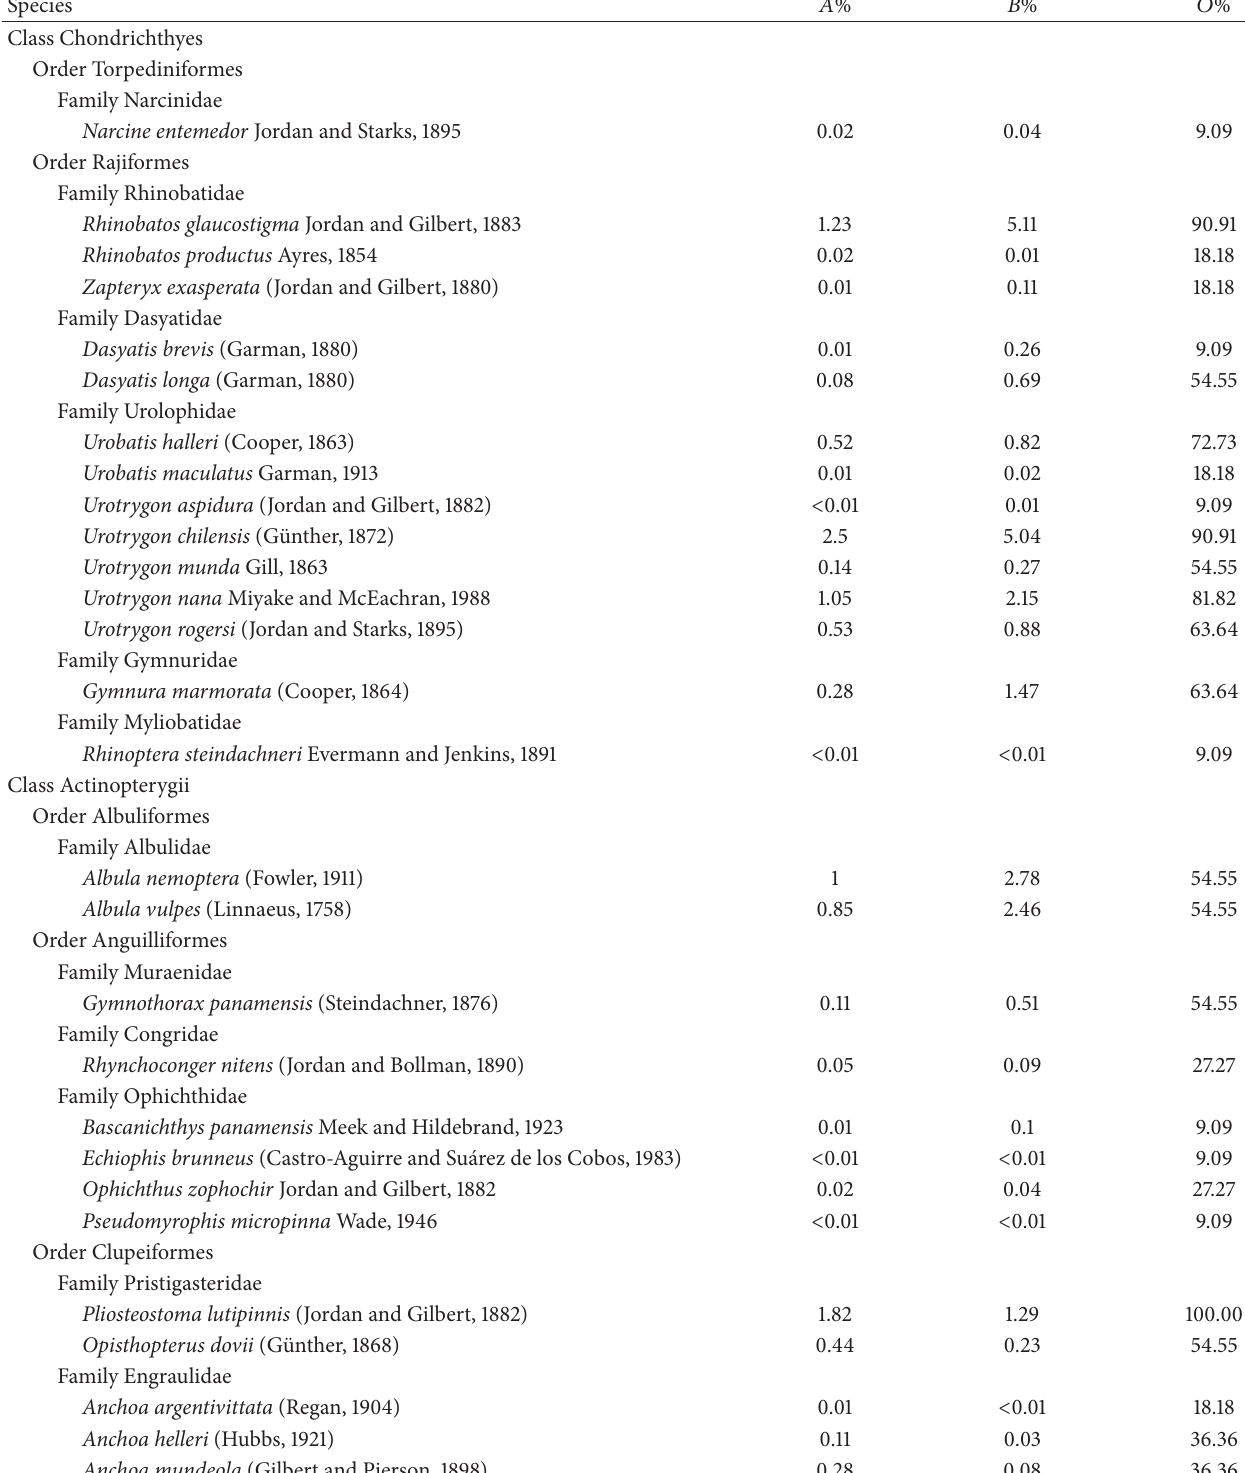
Table 1: Relative abundance ( 𝐴 %), relative biomass ( 𝐵 %), and frequency of occurrence ( 𝑂 %) of fish in Santa Mar´ıa la Reforma coastal lagoon, Gulf of